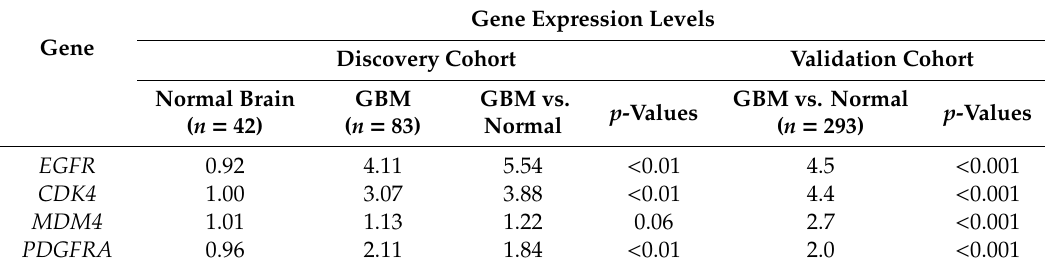
Table 1. Epidermal growth factor receptor ( EGFR ), cyclin dependent kinase 4 ( CDK4 ), mouse double minute 4 ( MDM4 ), and platelet-derived growth factor receptor alpha ( PDGFRA ) gene expression levels in glioblastoma multiforme (GBM) tissues from our series (assessed by RT-QPCR) and from the Gene